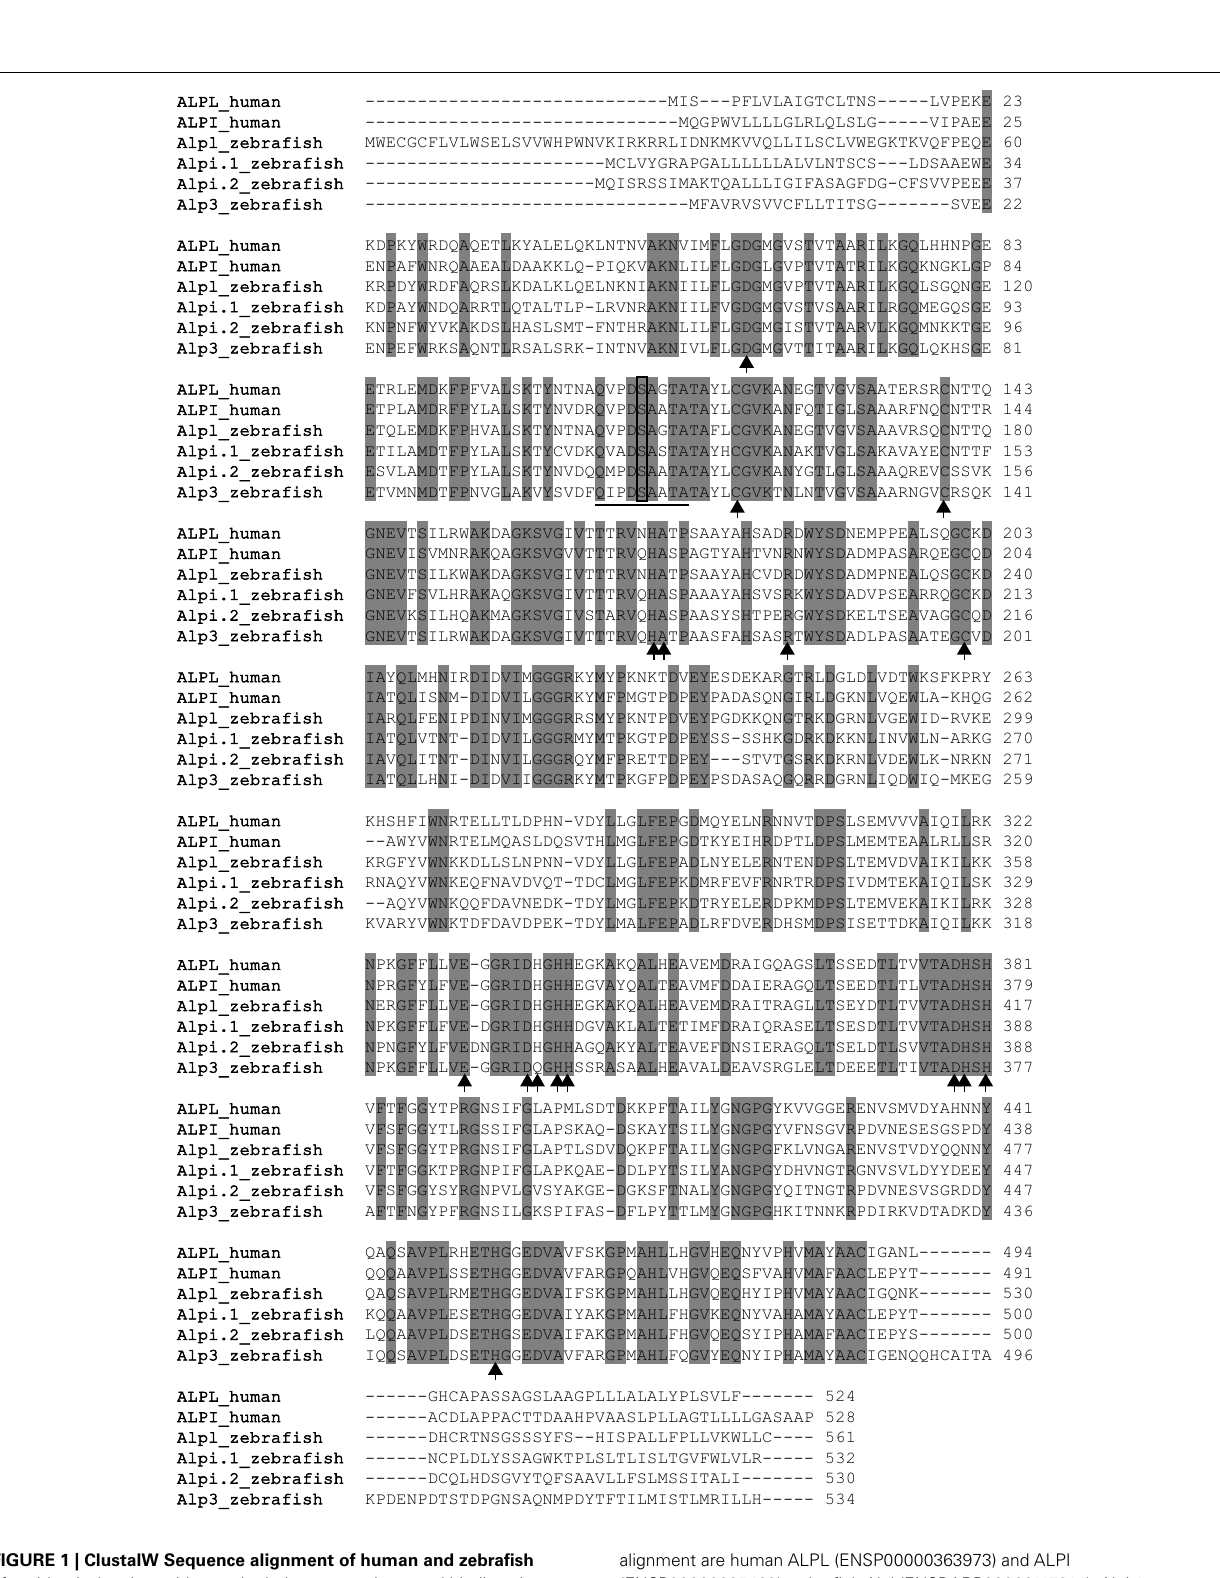
alignment are human ALPL (ENSP00000363973) and ALPI (ENSP00000295463); zebrafish Alpl (ENSDARP00000117214), Alpi.1 (ENSDARP00000016216), Alpi.2 (ENSDARP00000070354), and Alp3